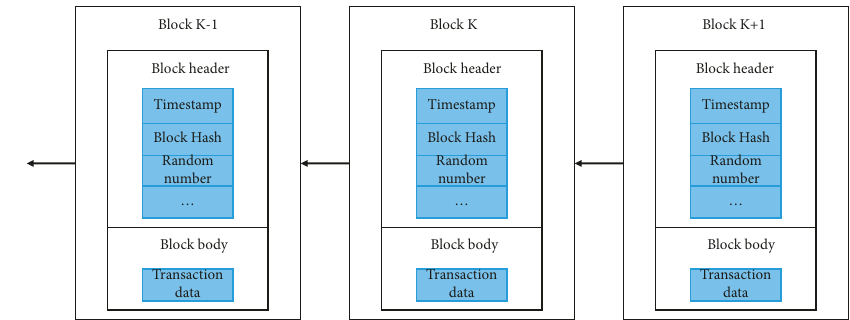
Figure 2: Block chain structure Table 2: Blockchain classification and comparison.